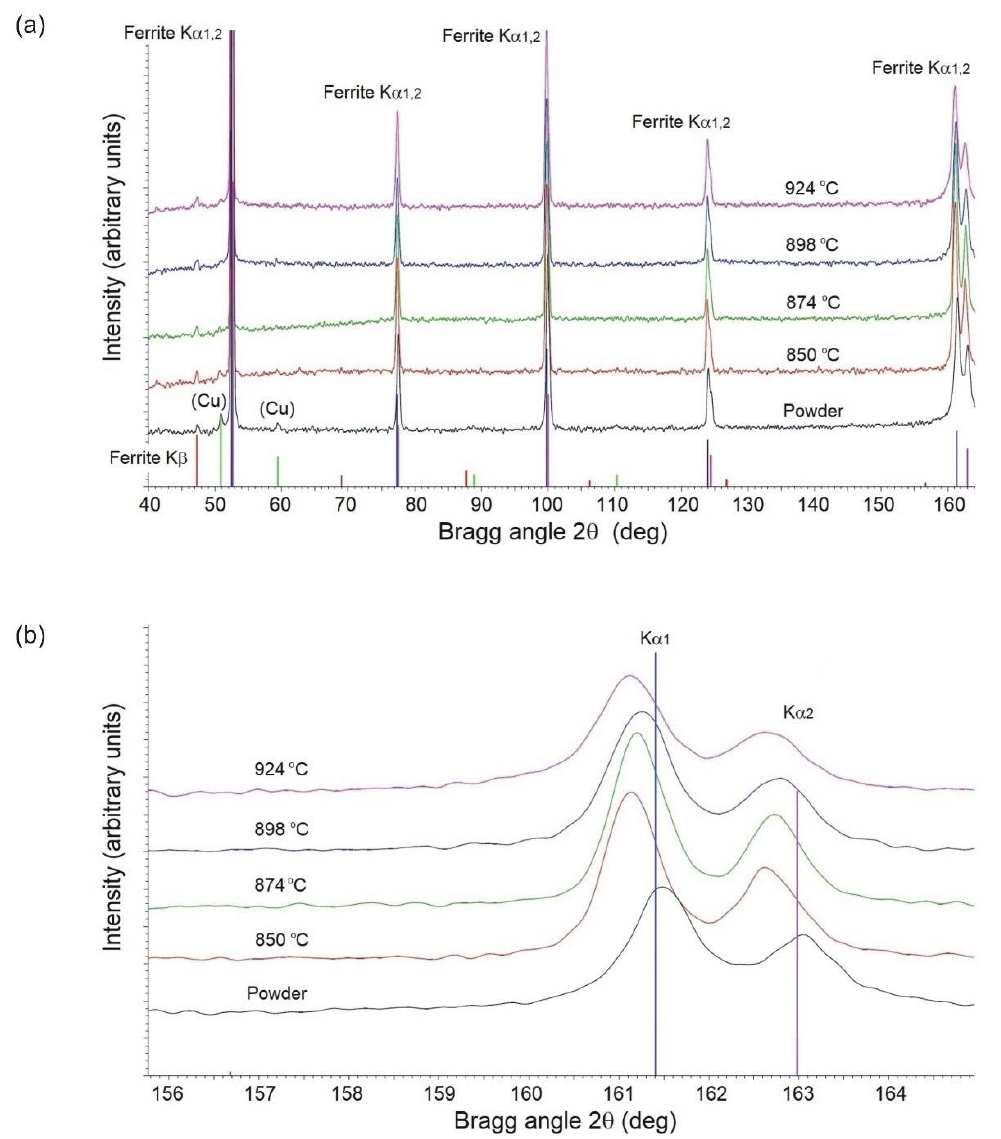
Figure 5. XRD patterns of the experimental steel ( a ) and a magnified view of the same graph showing positions of ferrite (310) peaks ( b ) used to calculate lattice parameters. Table 5. Volume fractions of (Cu) and lattice parameters of ferrite in the powder and sintered sam- ples.